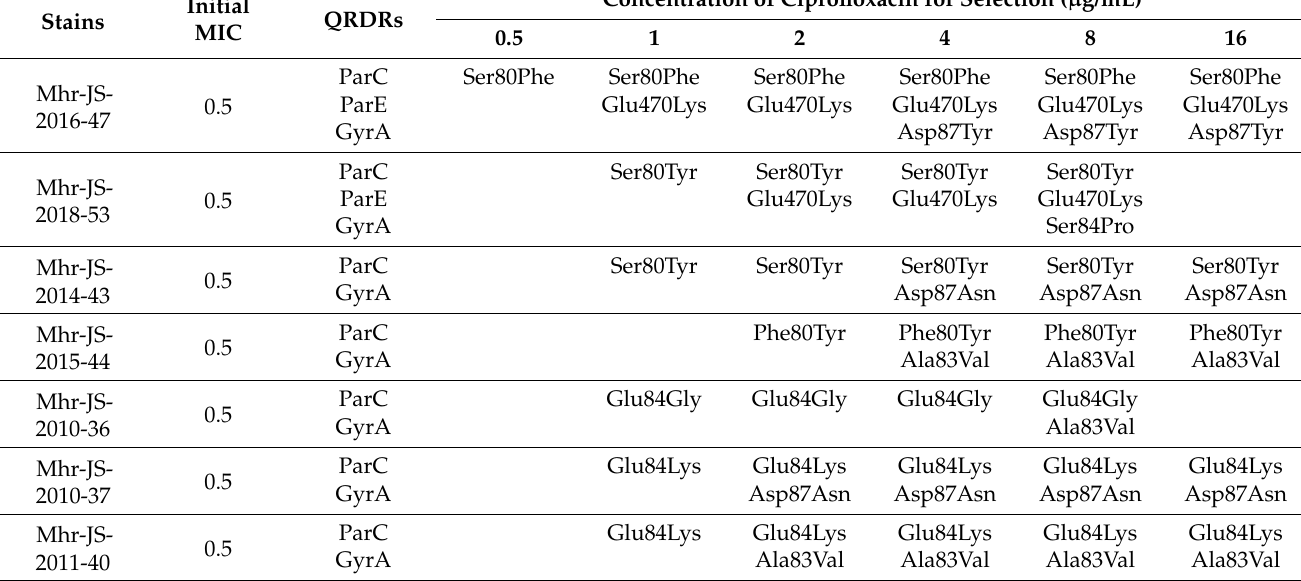
Table 2. The point mutations in the QRDRs of fluoroquinolones-resistant mutants collected at each selection